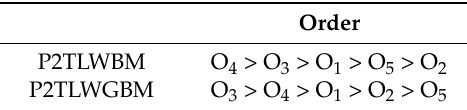
Table 4. Ordering of the green